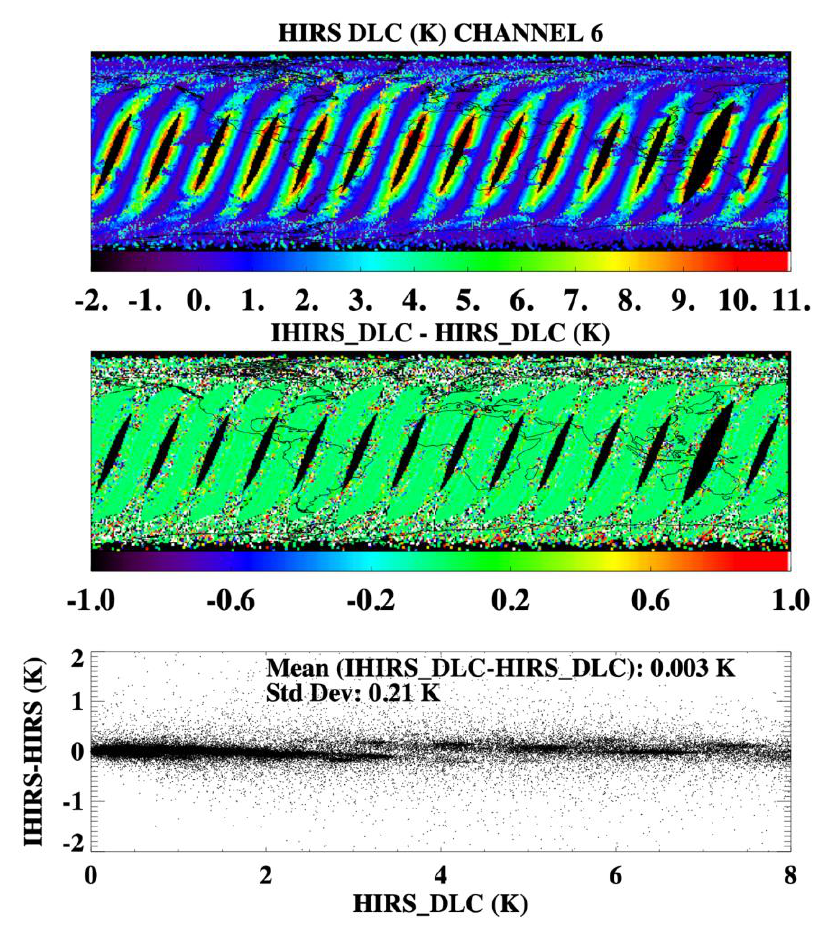
Figure 4. The difference in brightness temperatures with limb correction and without limb correction (represented as DLC) for 5 January 2011 for HIRS channel 6 (top) for descending orbits in the top panel, while the middle panel shows the geographical distribution of (IHIRS_DLC-HIRS_DLC). The bottom panel shows variation of the difference (IHIRS_DLC-HIRS_DLC) as a function of HIRS_DLC. Units for the color bar are in K.